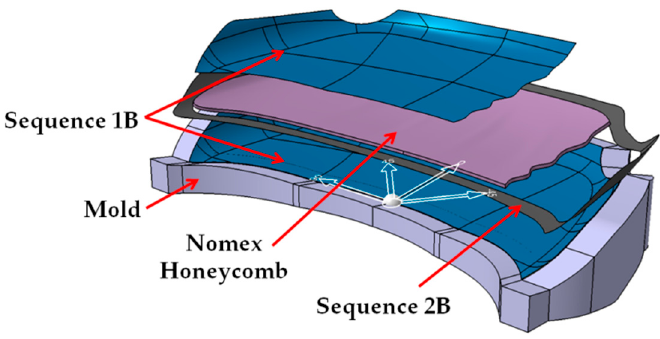
Figure 3. The stacking sequence of layers for the front hood: B. exterior